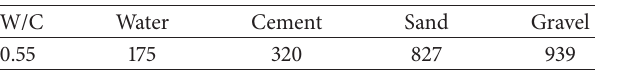
Table 1: Concrete mixture (kg/m 3